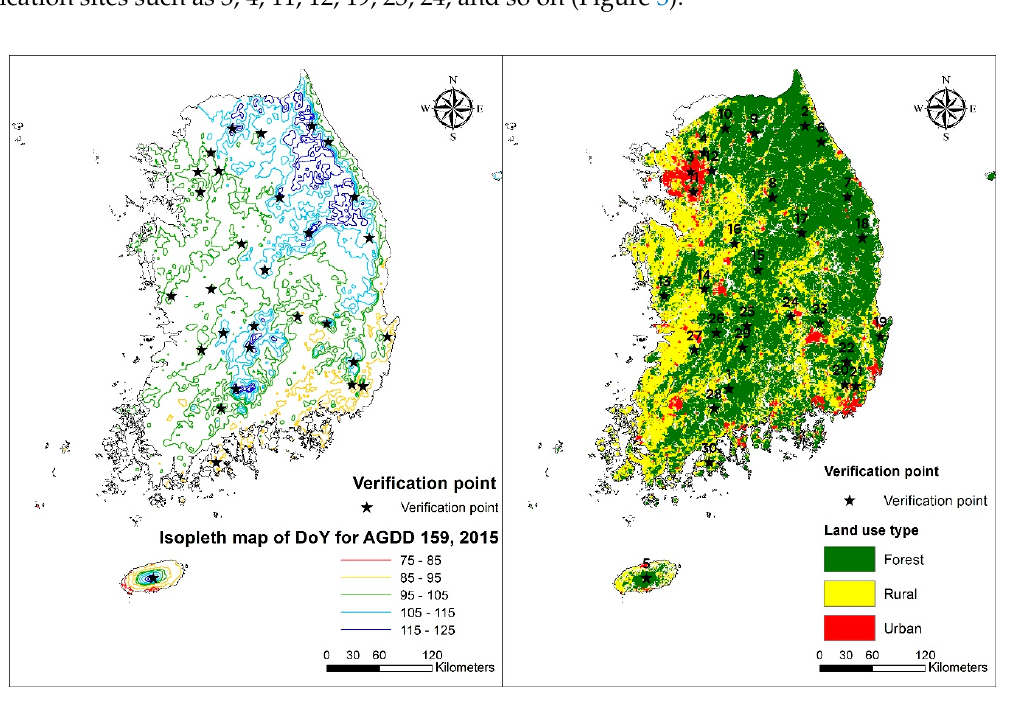
Figure 3. The isopleth map of day of year (DoY) for accumulated growing degree days (AGDD) 159 overlapped on the topography (left) and land-use type (right) maps.